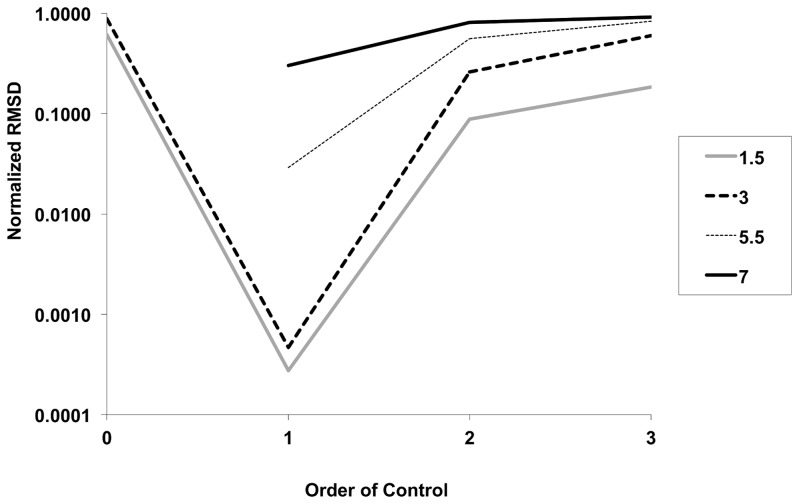
Model fits and “order of control”.Relationship between final-size-normalized root-mean squared differences (RMSD, Y-axis) between SIR model outputs and IDEA model fits, for R0 ranging from 1.5 to 7 (legend), with variation in order of control in SIR models (X-axis). It can be seen that for all R0 best-fits are achieved with first order control. Model fits were however better with low R0 simulations than with higher R0 simulations.